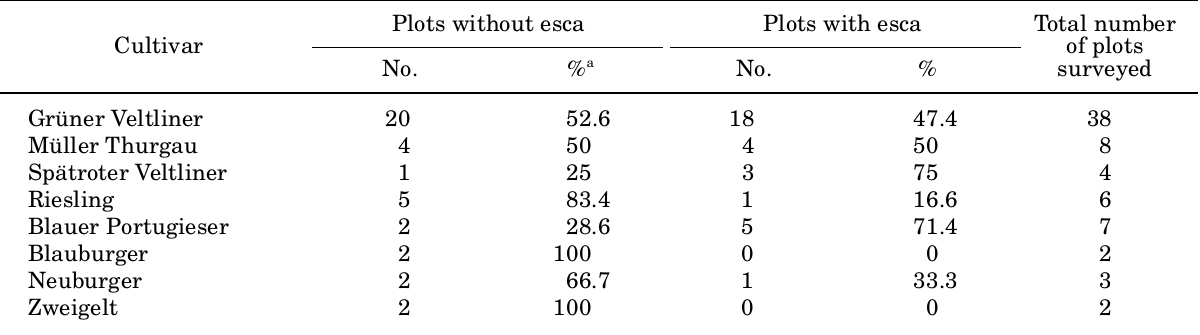
Table 2. Esca incidence versus grapevine cultivar. The statistical analysis of esca incidence and grapevine cultivars revealed that there was no association between these variables (Pearson chi-Square is 9.07, the P value is 0.336). Plots without esca Plots with esca Total number Cultivar of plots